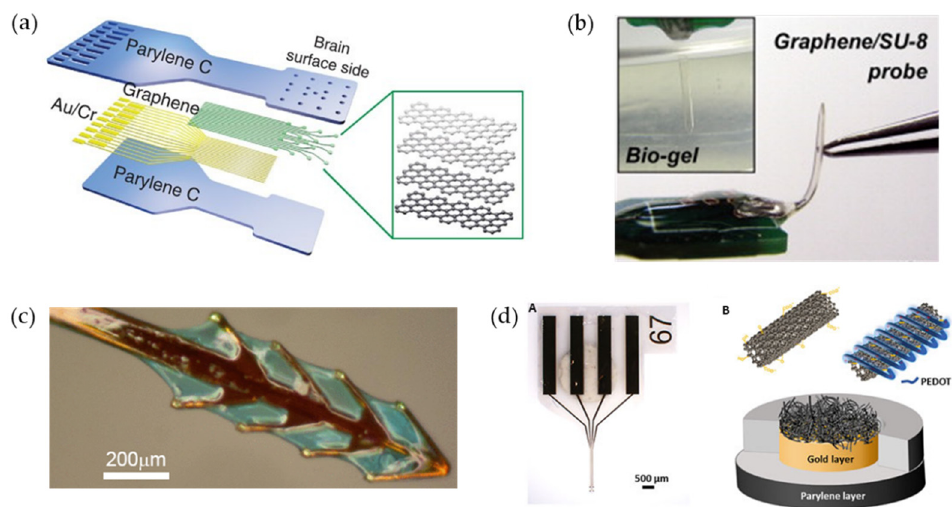
Figure 1. Different strategies for electrode flexibility. ( a ) Schematic of the electrode with flexible Parylene probes [52]. Reprinted under a Creative Commons Attribution (CC BY) license. ( b ) Optical micrographs of the flexible SU-8 probe with 90° bending and penetrate an agar gel. Reprinted from [54], Copyright (2013), with permission from Elsevier. ( c ) Microscope image of the fishbone-shaped polyimide neural probe [55]. ( d ) Nanomaterials PEDOT-CNF to improve electrode performance: A—Optical micrograph of the neural probe; B—Schematic diagram of the PEDOT-CNF composite deposition [66]. Reprinted under a Creative Commons Attribution (CC BY) license.